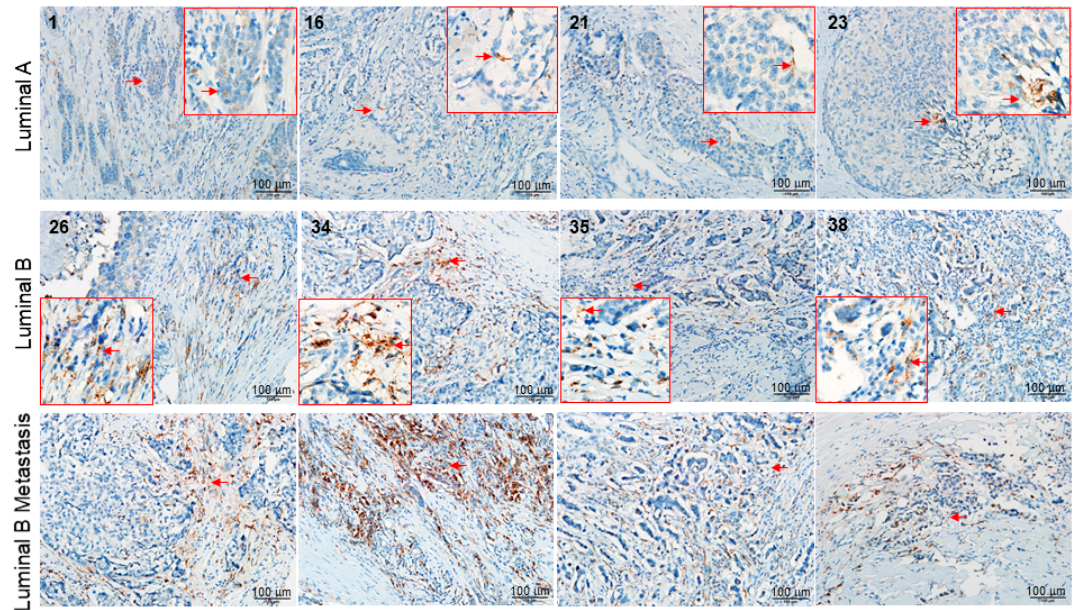
Figure 3. Immunohistochemical study of cathepsin D expression in luminal A, B subtypes of breast cancer tissues and metastastic lymph nodes obtained from luminal B subtype. The positive signal was presented in brown color and indicated by red arrows, which was zoomed in and shown by red square.